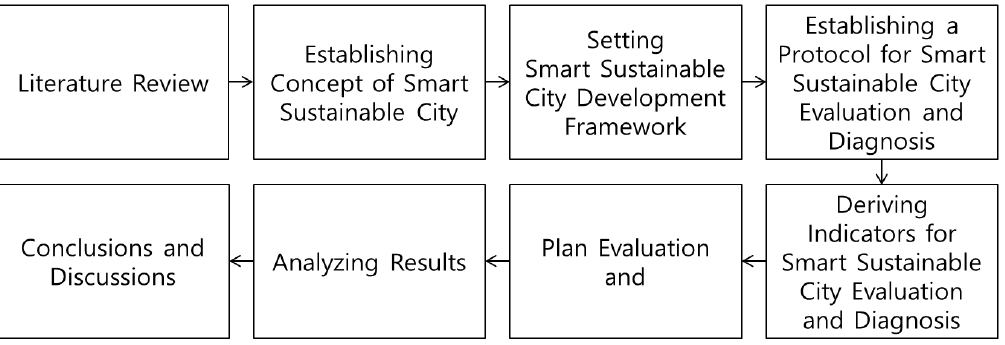
Figure 1. Research